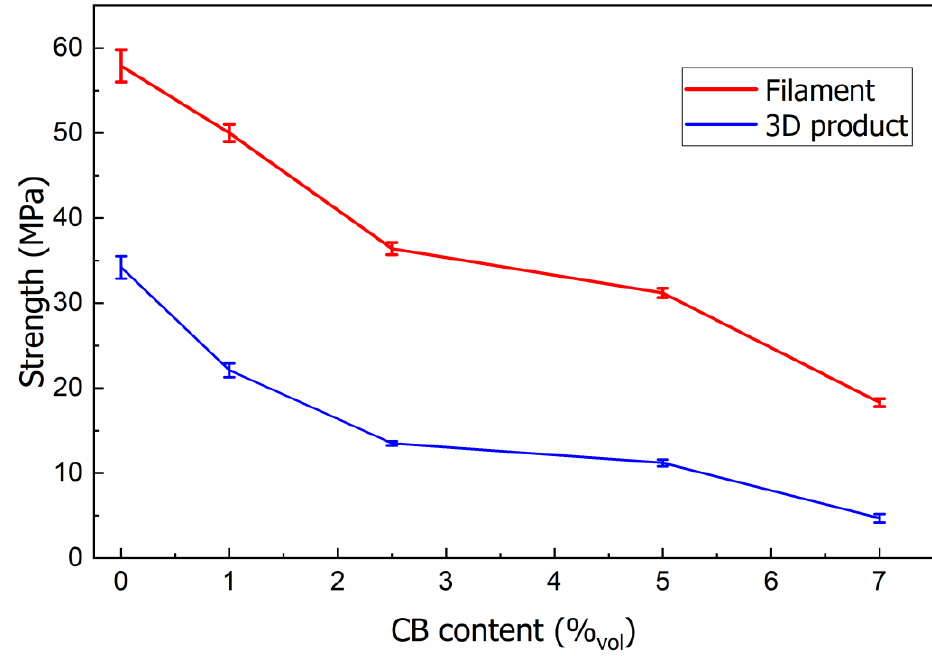
Figure 15. Dependences of mechanical strength of specimens on CB content.